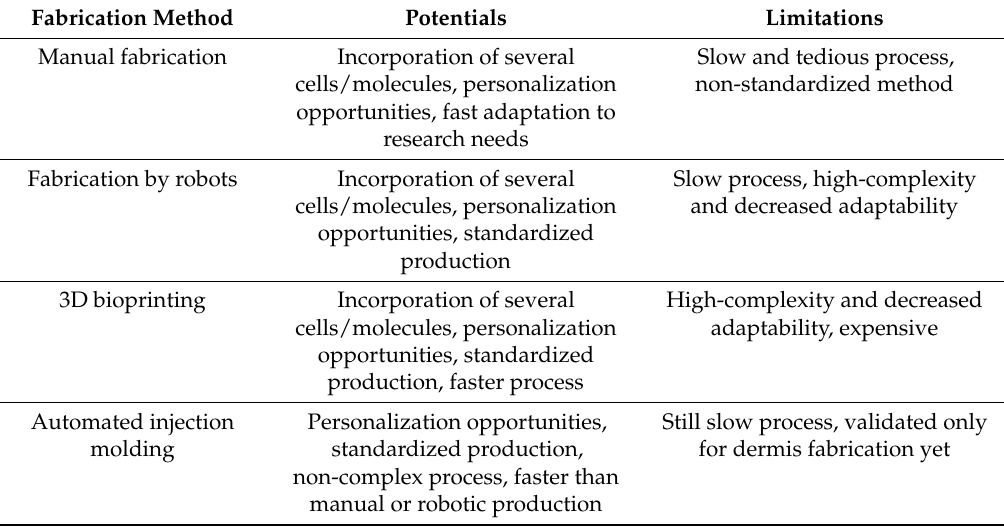
Figure 6. Components of injection molding process [46]. Left : Double cartridge, containing high concentration collagen in the left container and fibroblasts suspension in the right container, along with a mixing nozzle in which the contents are mixed and then injected into the encased mold. Right : in-mold dermal hydrogel (pink color due to fibroblasts culture medium). Table 2. Available fabrication methods of skin models along with their potentials and